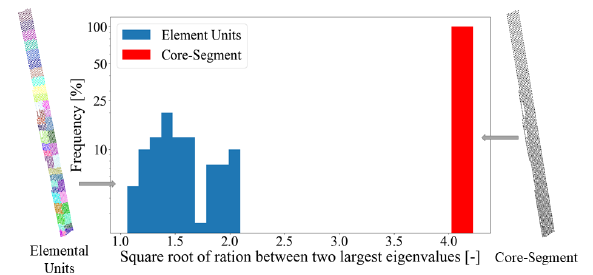
Figure 4: Analysis of object shape: Extracted elemental units compare to and their respective core-segment patches when analyzed in their elemental unit form Fig. (4). On